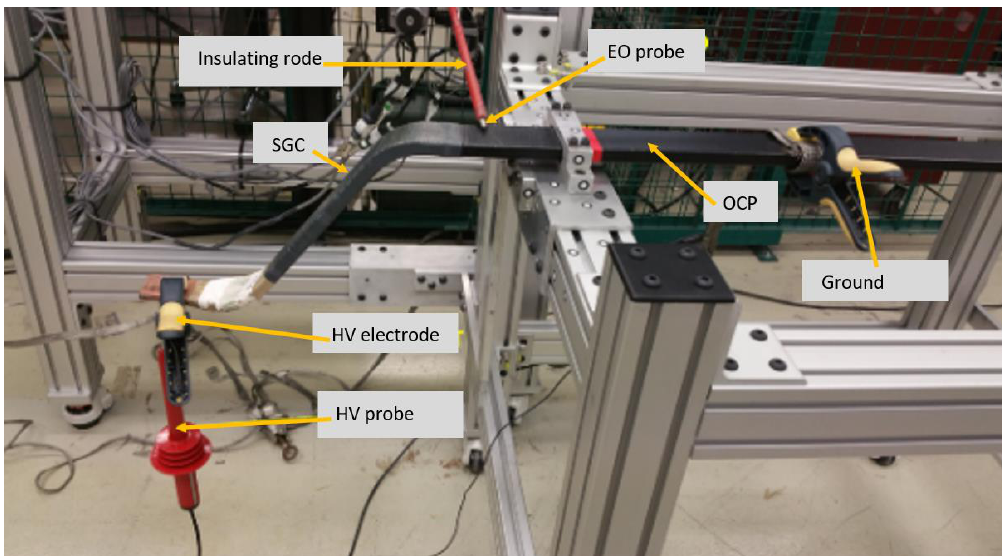
Figure 4. Experimental setup built and installed at the IREQ (Institut de Recherche d’Hydro-Québec) laboratory for the E-field mapping.